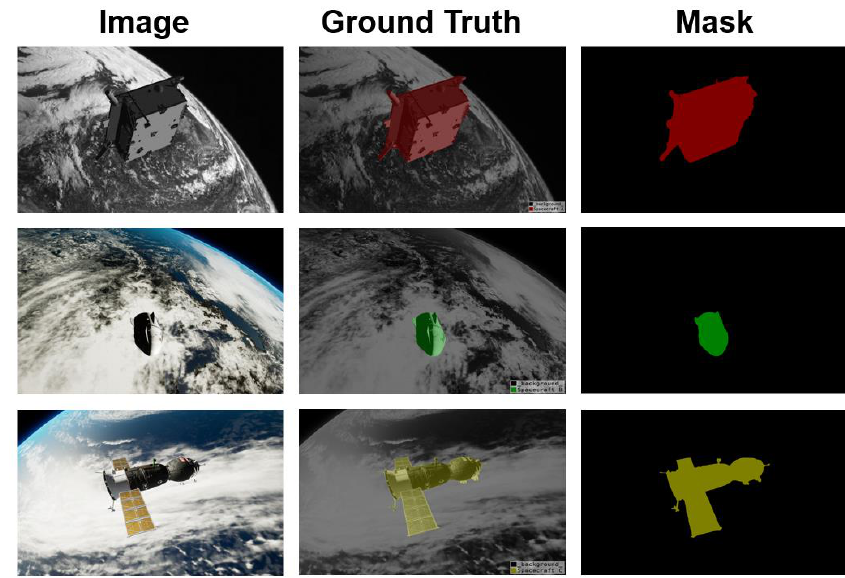
Figure 1. The display of our